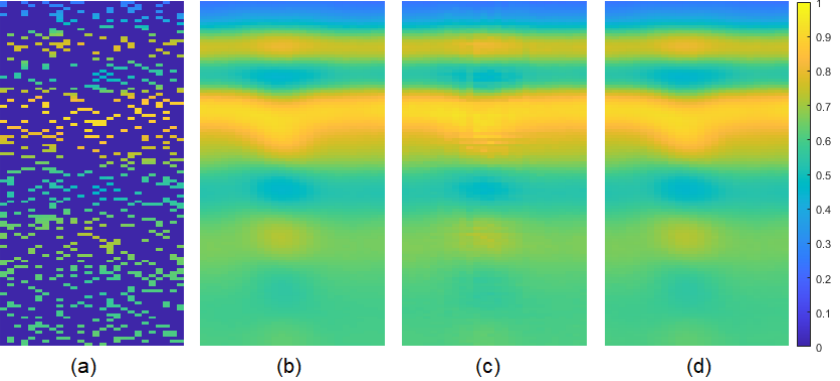
Figure 17. 80% pixel-wise missing data case for the zoomed target (third one) of real data-I: ( a ) GPR im- age with missing entries, recovered images by ( b ) original GPR image, ( c ) NNM zoomed , ( d ) DIP zoomed